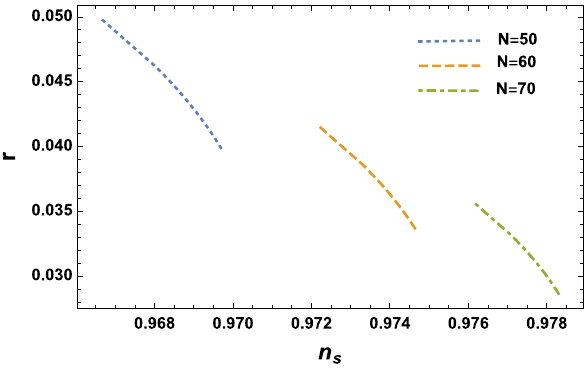
Fig. 16 The variation of (cid:10) 0 , (cid:10) 1 ,... during inflation, for α = 5 × 10 6 , Fig. 17 n s vs r for η = 0 . 2, φ 0 = 10 − 3 M p and 1 ≤ β ≤ 10 10 . η = 0 . 2 and f = 10 − 3 M α = β V p . Note that 0 , where V 0 is fixed by The three curves correspond to N = 50 , 60 , 70. On average, over the COBE normalization β -interval, n ∼ 10 − s and r vary only in